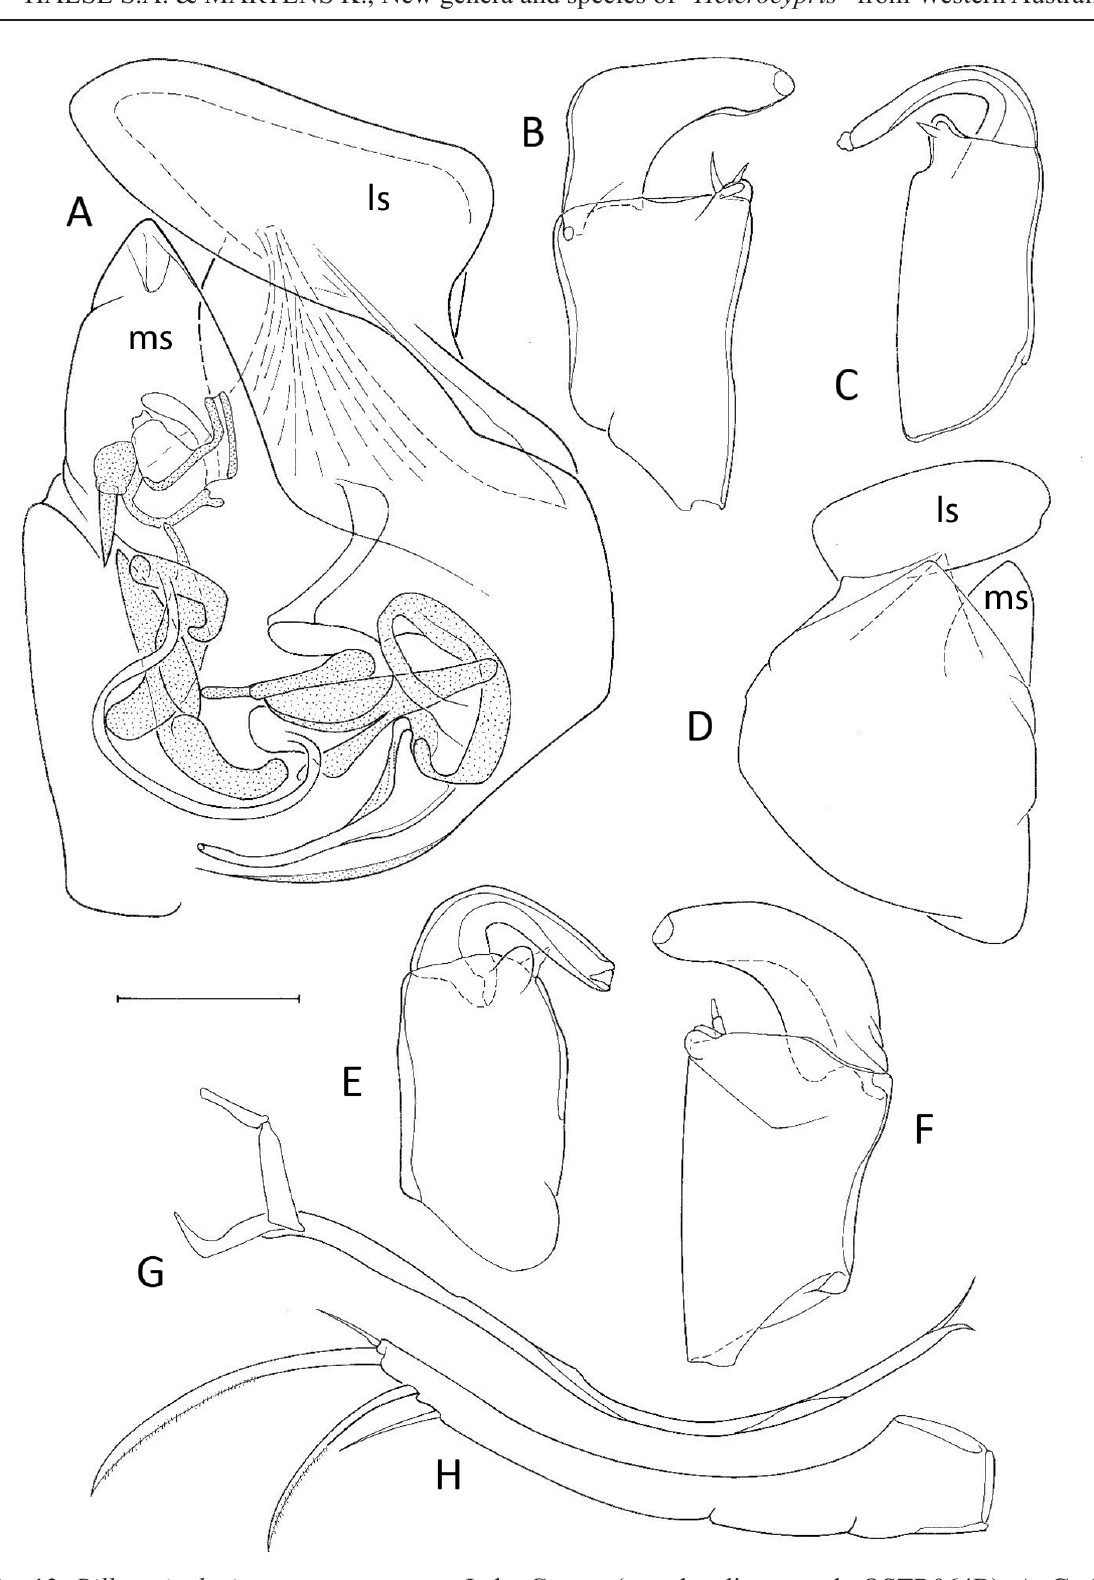
Fig. 13. Billcypris davisae gen. et sp. nov., Lake Cowan (type locality, sample OSTR064B). A–C . ♂, holotype (WAM 67217). A. Hp. B. Rpp. C. Lpp. D–F . ♂, paratype (RBINS INV 138038). D. Hp